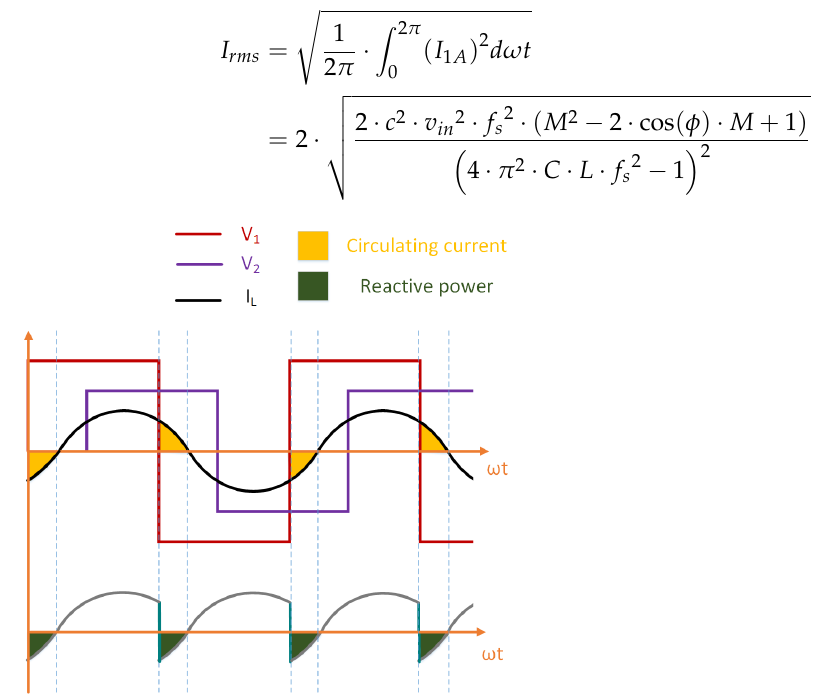
Figure 14. Reactive power and circulating current with SPS